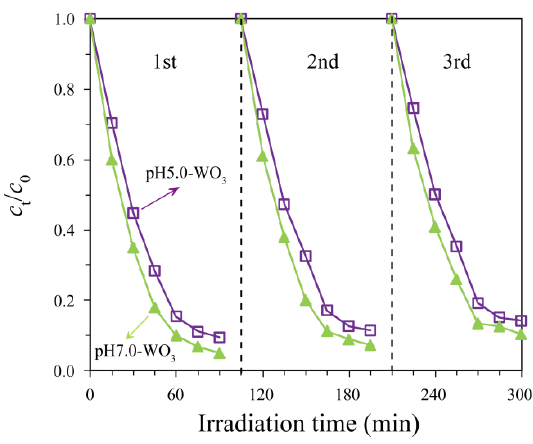
Figure 11. Cyclic degradation curves of pH5.0-WO 3 and pH7.0-WO 3 for methylene blue solution.